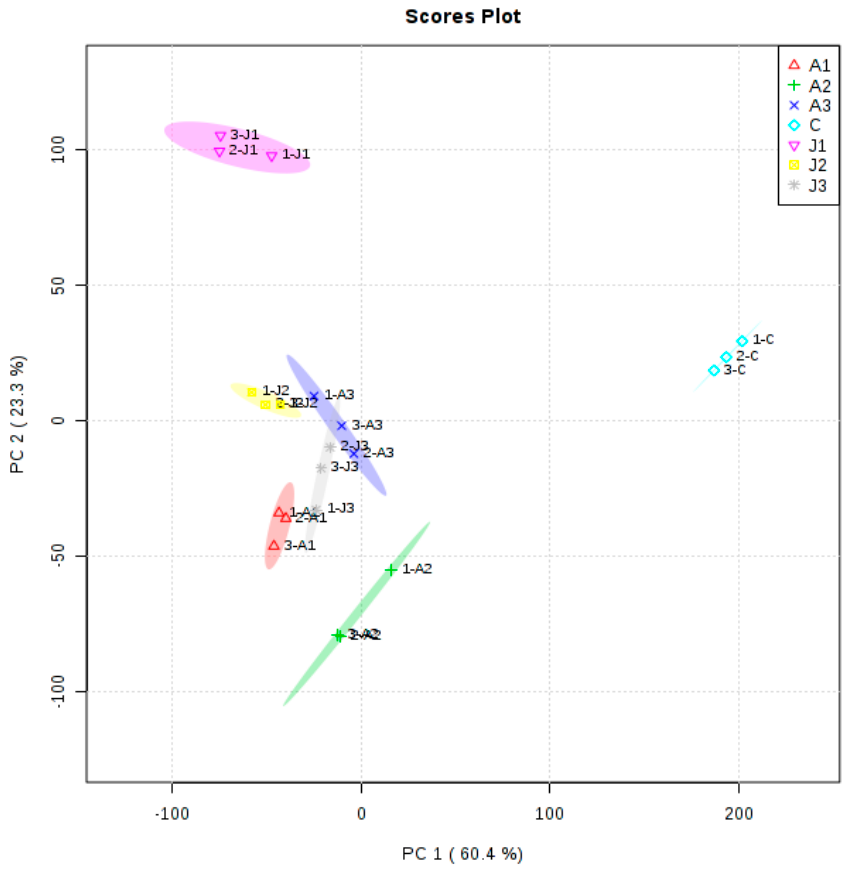
Figure 4. PCA scores plot of samples after different treatments. The colored dots represent samples from different treatments. Seven independent treatment studies, each with triplicate samples, were used in the analysis. A1: treatment with 1000 mg · L − 1 ABA; A2: treatment with 600 mg · L − 1 ABA; used in the analysis. A1: treatment with 1000 mg·L − 1 ABA; A2: treatment with 600 mg·L − 1 ABA; A3: A3: treatment with 200 mg · L − 1 ABA; J1: treatment with 800 µ mol · L − 1 MeJA; J2: treatment with treatment with 200 mg·L − 1 ABA; J1: treatment with 800 µmol·L − 1 MeJA; J2: treatment with 200 µmol·L − 1 200 µ mol · L − 1 MeJA; J3: treatment with 50 µ mol · L − 1 MeJA; C: MeJA; J3: treatment with 50 µmol·L − 1 MeJA; C: control.